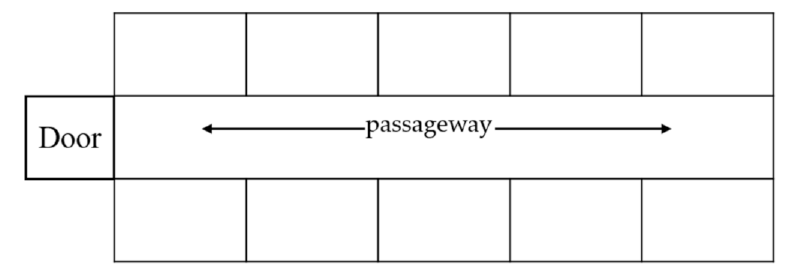
Figure 1. Schematic view of the experimental pig